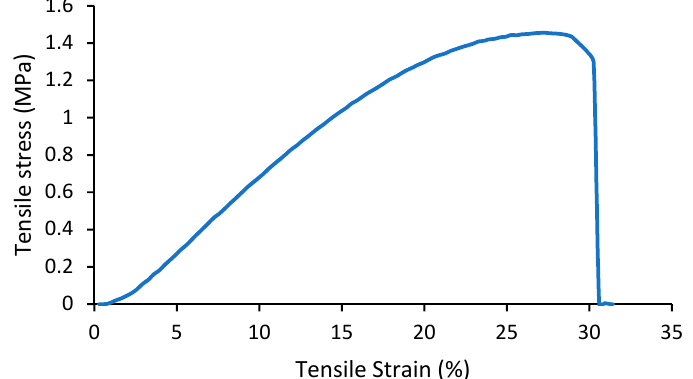
Figure 9. Mechanical properties of Bup/PVP/PVA nanofibers.